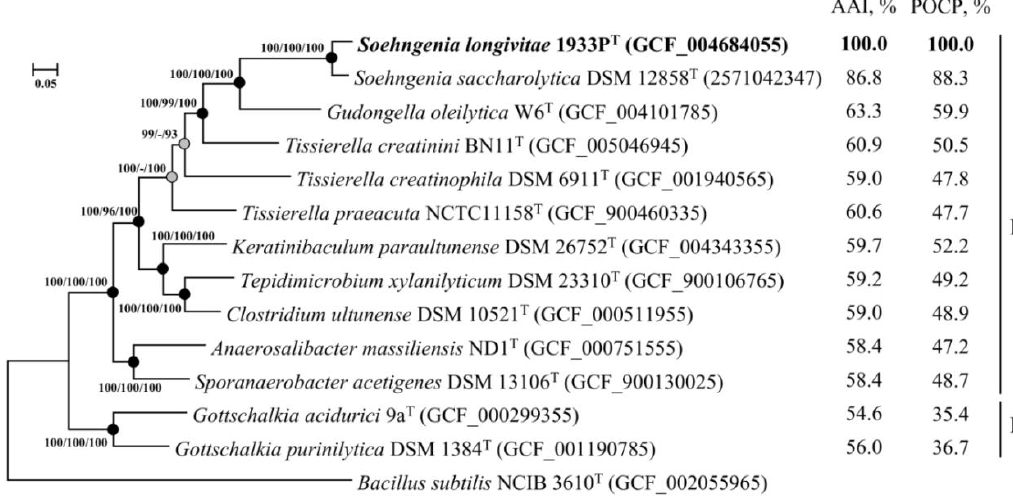
Figure 3. Maximum-likelihood phylogenetic tree derived from concatenated 120 single copy marker proteins showing the position of strain 1933P T in relation to taxonomically characterized members of the families Tissierellaceae (I) and Gottschalkiacecae (II). Phylogenetic analysis was performed with an LG + F + I + G4 model based on 34,747 amino acid positions. Scale bar, 0.05 amino acid substitutions per site. The tree was rooted using Bacillus subtilis NCIB 3610 T as the outgroup. Accession numbers for the genomes are indicated in brackets. The average amino acid identity (AAI) and pairwise percentage of conserved proteins (POCP) values refer to strain 1933P T compared to the rest of the species.